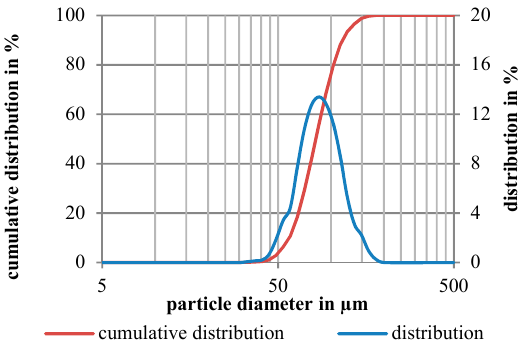
Figure 8. Particle size distribution of the used 316L-Si powder.